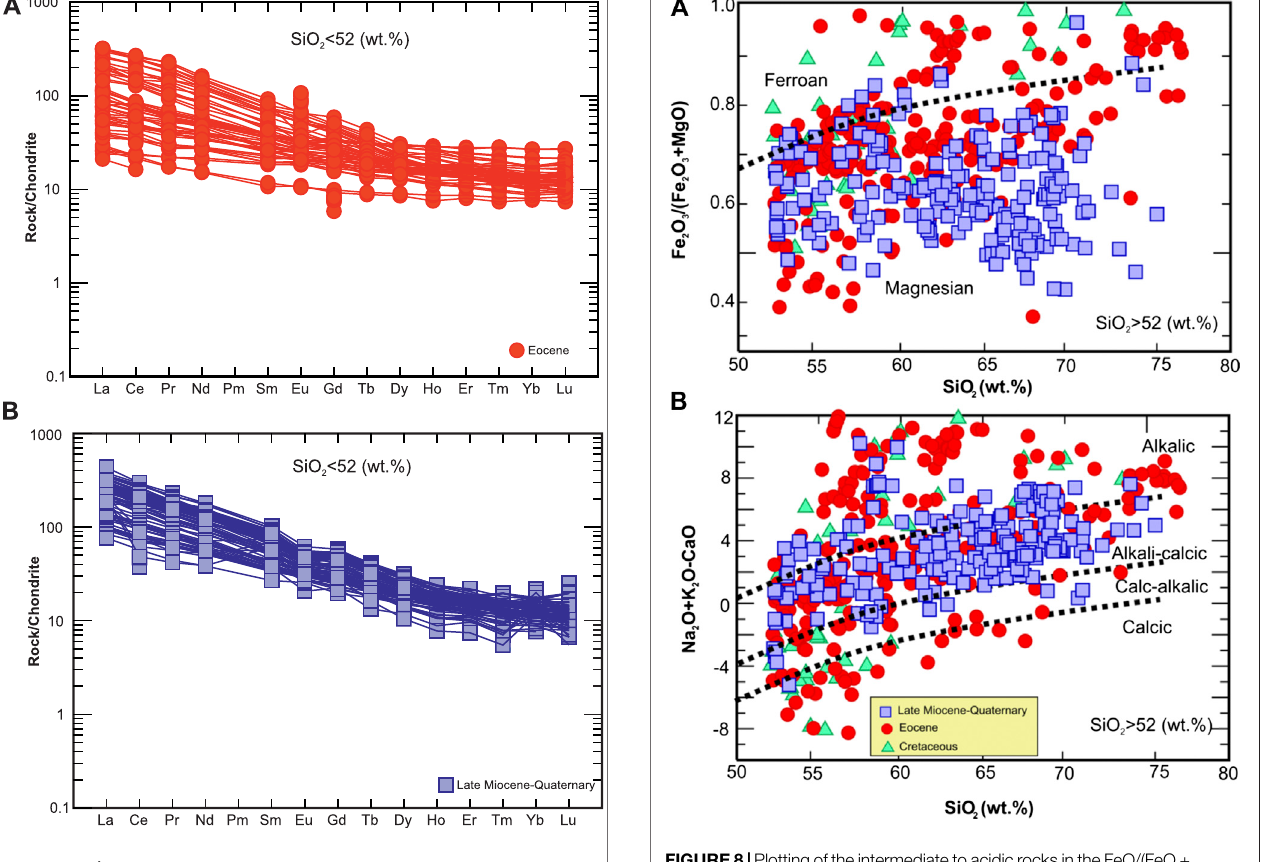
Frontiers in Earth Science |